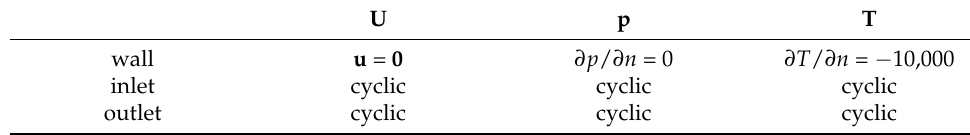
Figure 2. Schematic representation of the boundary conditions used. Table 1. Definition of the boundary conditions used.